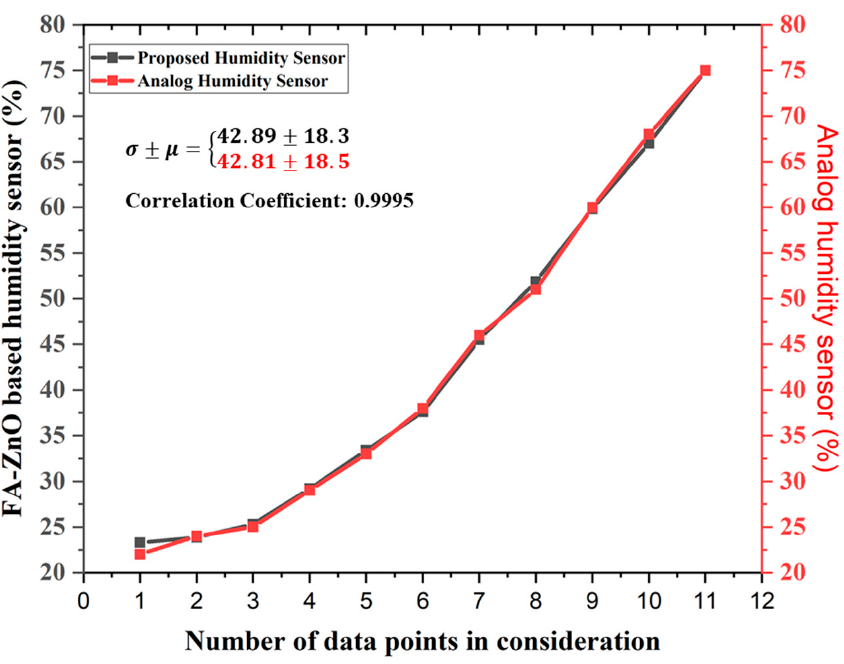
Figure 10. Validation of the proposed sensor by corroboration with the commercial analog humidity Figure 10. sensor.